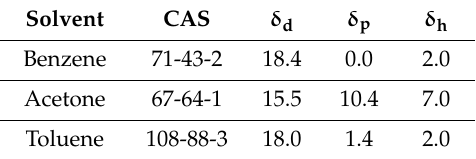
Table 3. Hansen solubility parameters of each organic solvent.